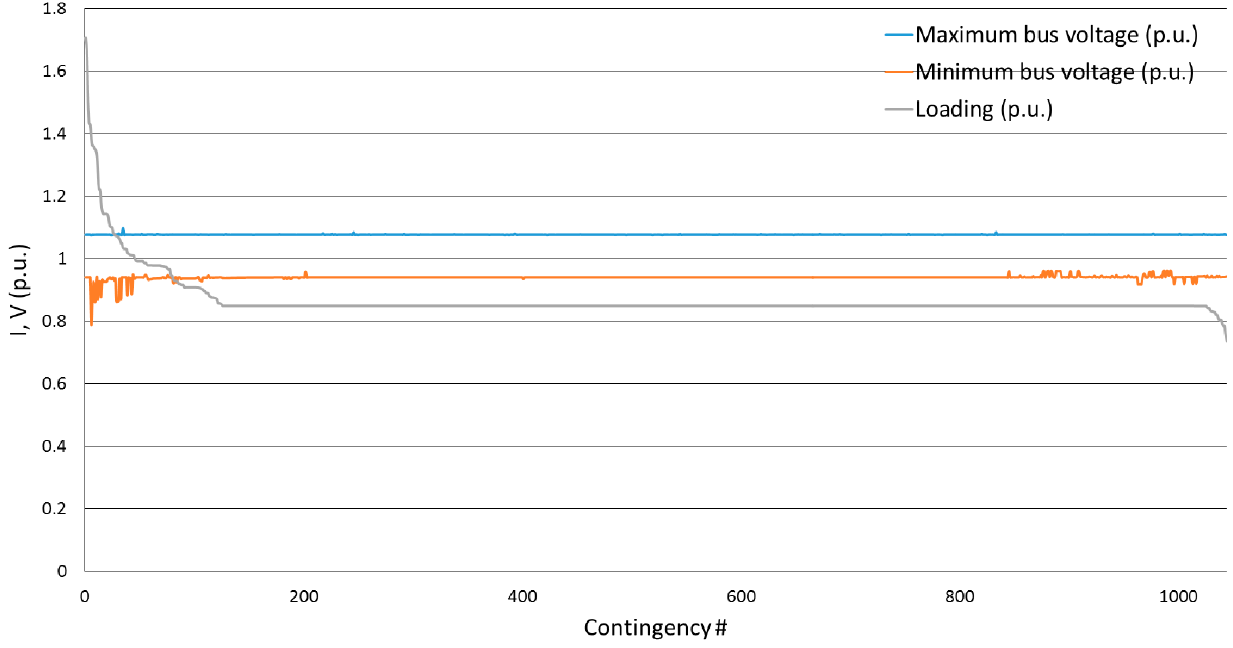
Figure 6. Maximum branch loading (grey line, in per unit of the rated branch capacity), maximum bus voltage (blue line, in per unit of the rated bus voltage) and minimum bus voltage (orange line, in per unit of the rated bus voltage) caused by each contingency.